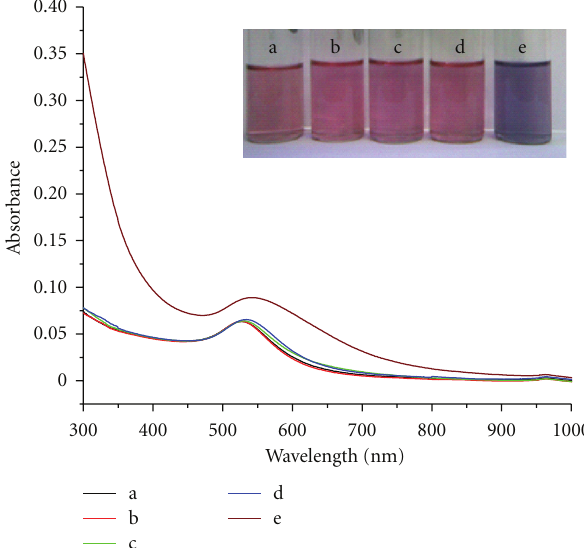
Figure 6: UV-vis spectra of PVP stabilized AuNPs (pH = 12) with various metal ions; (a) no metal ion (blank), (b) Pb 2+ (c) Ca 2+ (d) Zn 2+ and (e) Hg 2+ ; Inset. Photographic images show various metal ion in PVP-stabilized AuNPs (pH = 12); (a) no metal (blank), (b) Pb 2+ , (c) Ca 2+ , (d) Zn 2+ , and (e) Hg 2+